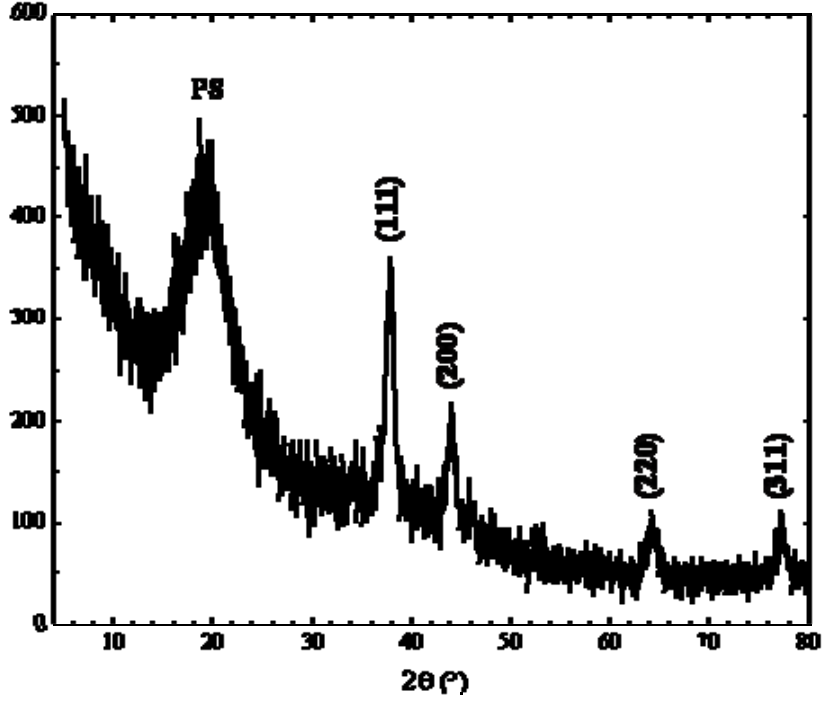
Figure 5. XRD-diffractogram of a silver-polystyrene nanocomposites sample obtained by annealing a AgSC H /polystyrene 12 25